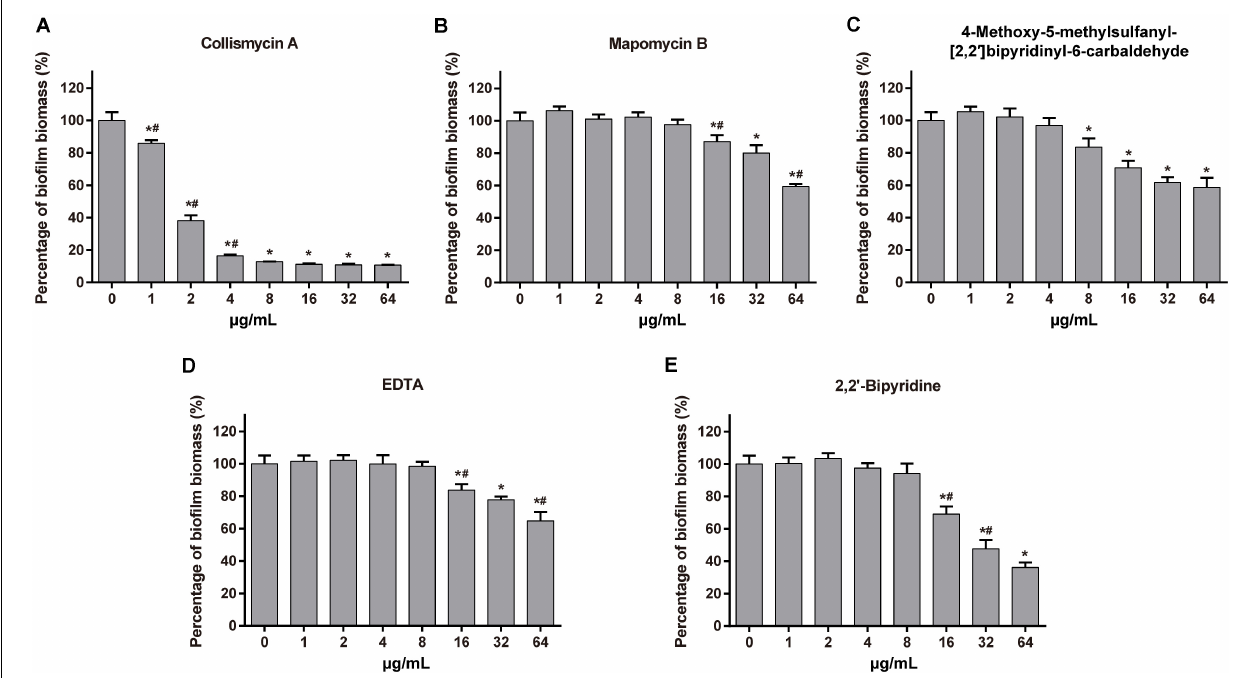
FIGURE 5 | Effect of maipomycin A (MaiA) analogs and synthetic chelators on A. baumannii ATCC 19606 biofilm formation. The anti-biofilm activity of tested compounds against A. baumannii ATCC 19606 biofilm at different concentrations was quantified by CV stain. The compounds were as follows: (A) Collismycin A, (B) Maipomycin B, (C) 4-Methoxy-5-methylsulfanyl-[2,2 (cid:48) ]bipyridinyl-6-carbaldehyde, (D) EDTA, and (E) 2,2 (cid:48) -dipyridyl. *Indicates P < 0.05 compared with untreated controls. # Indicates P < 0.05 compared with the previous